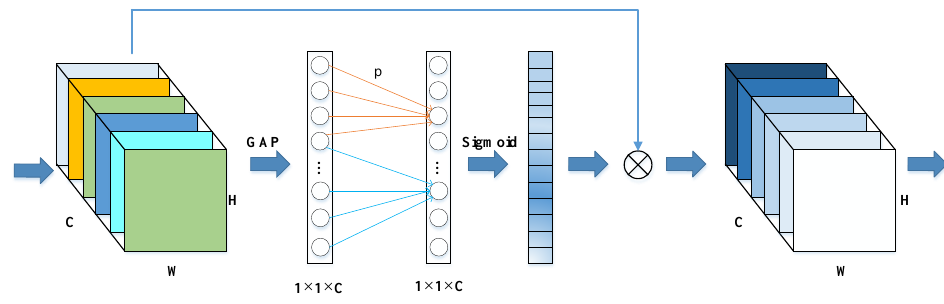
Figure 6. The specific structure of ECA. The input feature maps’ height and width are represented by H and W, and C is the number of channels. p represents the required adjacent channels to obtain the cross-channel interaction information of each channel and can be adaptively determined via a mapping of C. Sigmoid is the activation